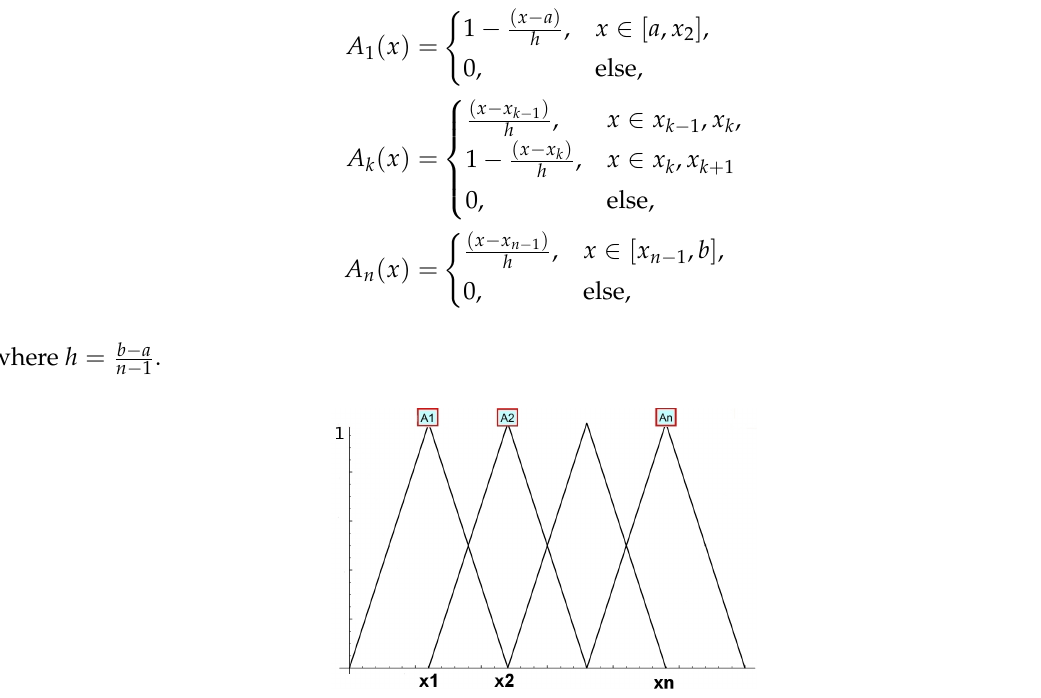
Figure 1. An example of a uniform fuzzy partition [ x 1 , x n ] = [ a , b ] by triangular membership